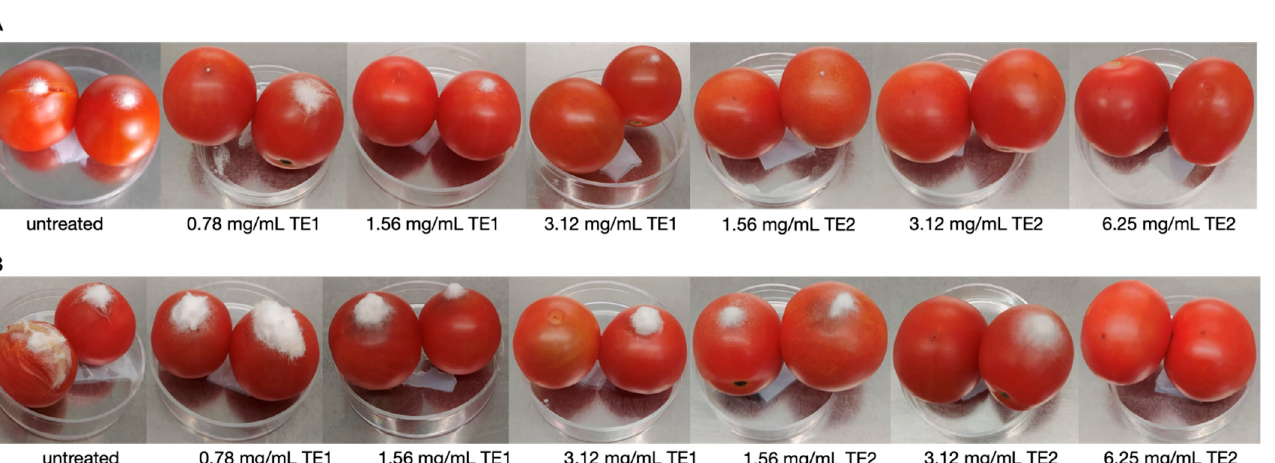
Figure 4. Mycelium growth of Fusarium graminearum on tomatoes treated with TE1, TE2 and untreated at ( A ) 4 and ( B ) 11 days incubation.